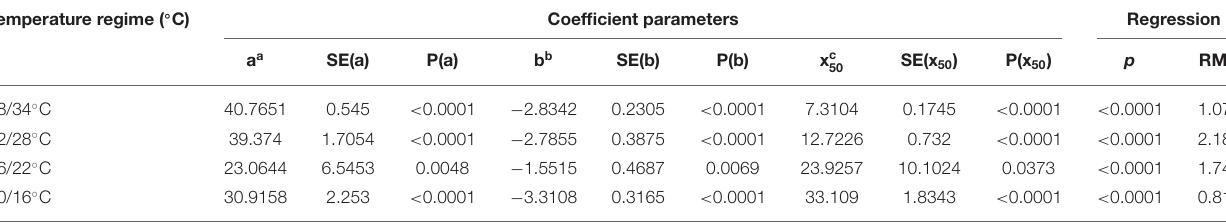
TABLE 3 | Three-parameter logistic nonlinear regressions between A. artemisiifolia emergence and time (days). Temperature regime ( ◦ C) Coefficient parameters